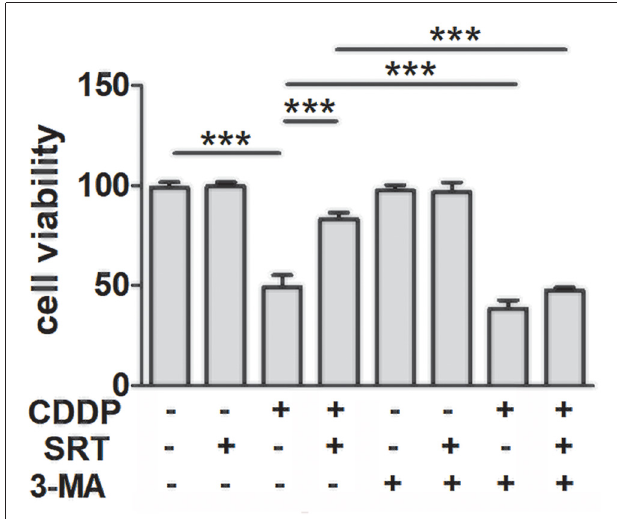
FIGURE 4 | SIRT1 protects against cisplatin-induced cell death via autophagy in HEI-OC1 cells. The CCK8 assay was performed to examine cell viability of HEI-OC1 cells in CDDP (20 µ M) exposure for 24 h combined with 3-MA (5 mM) treatment with or without SRT1720 pre-treatment for 24 h (0.5 µ M; n = 4 individual experiments). Data represent the mean ± SEM. ∗∗∗ p < 0.001. CDDP, cisplatin; SRT, SRT1720; 3-Methyladenine,